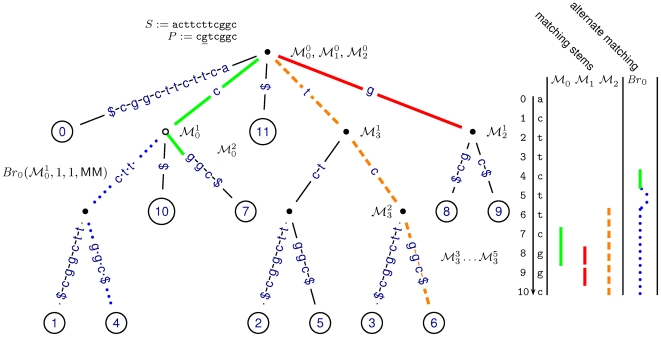
Matching stems and matching branches.We give an explanation based on a suffix trie which is equivalent to the suffix interval tree shown in Fig. 5 (see Methods). The suffix trie for S$ with S: = acttcttcggc (left) holds twelve leaves. Each numbered leaf corresponds to exactly one suffix in S. Nodes with only one child are not explicitly shown. Note, that internal nodes implicitly represent all leafs in their respective subtree. Thus, internal nodes can be regarded as sets of suffixes. The right panel holds the longest matches for different matching paths in the trie. Matching the first three suffixes of the read P: = cgtcggc results in three different paths in the suffix trie. Each path is equivalent to a sequence of suffix intervals, a matching stem, in the enhanced suffix array. Let  denote the matching stem for Pi = ith suffix of P. The qth interval in , denoted by , implicitly represents the set of suffixes in S matching P[i‥i+q−1]. The path for the first suffix P
0 is of length two (green solid line). Hence, the equivalent matching stem  is a sequence of three intervals: ,  and . Since  only represents the suffix S
7, the longest prefix match of P
0 is of length 2 occurring at position 7 of the reference sequence (right panel). The matching stem  for P
1 (red solid line) ends with . Therefore, matches of length one occur at positions 8 and 9 in S. The longest prefix match for P
3 occurs at position 6 of S (dashed orange line). Note, that the intervals  of  equivalently represent S
6. An alternative path leads to a match with position 4. The branch  denotes the alternative that accepts the mismatch of g and t at position 1 of P
0.